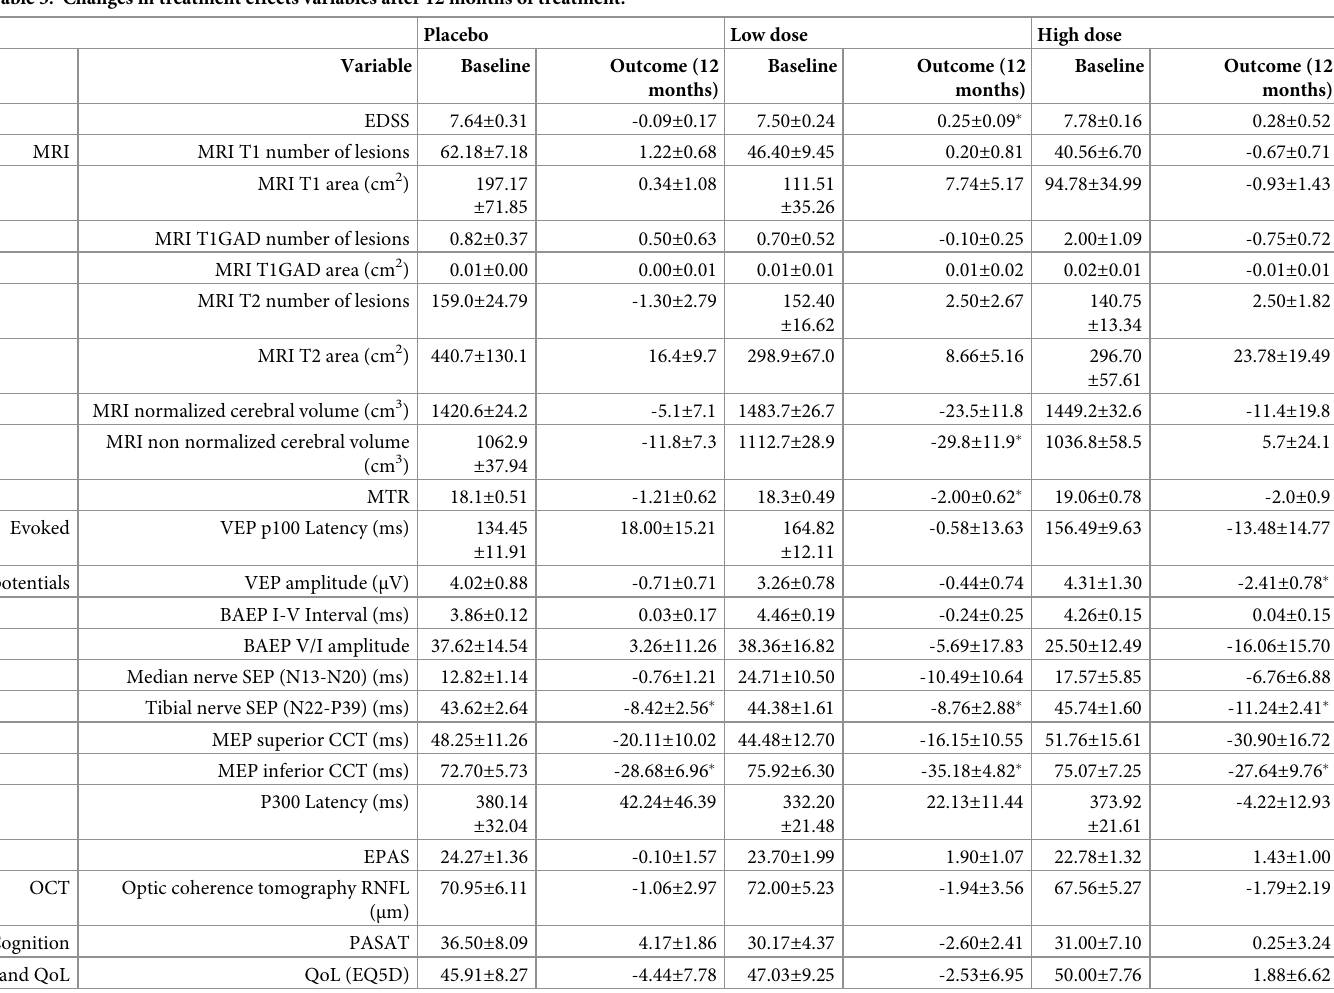
Table 3. Changes in treatment effects variables after 12 months of